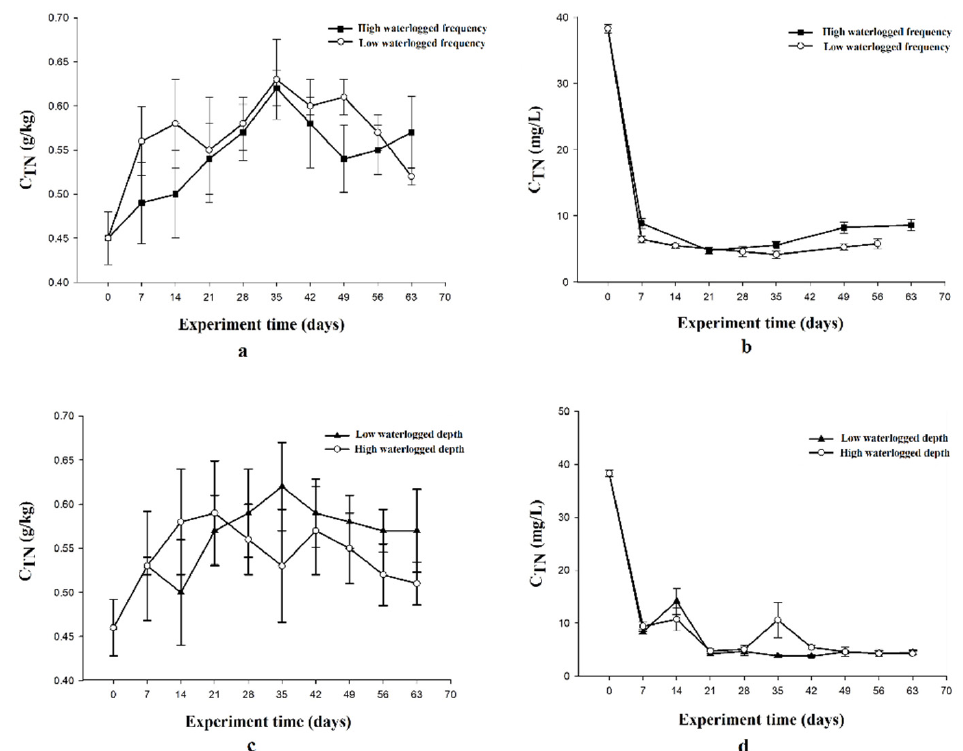
Figure 4. Dynamic changes in total nitrogen content of soil and effluent under different waterlogged conditions. ( a ) The dynamic changes in soil TN content under different waterlogged frequencies applied to the average of waterlogged depth option; ( b ) The dynamic changes in effluent TN content under different waterlogged frequencies applied to the average of waterlogged depth option; ( c ) The dynamic changes in soil TN content under different waterlogged depths applied to the average of waterlogged frequencies option; ( d ) The dynamic changes in effluent TN content under different waterlogged depth applied to the average of waterlogged frequencies option.